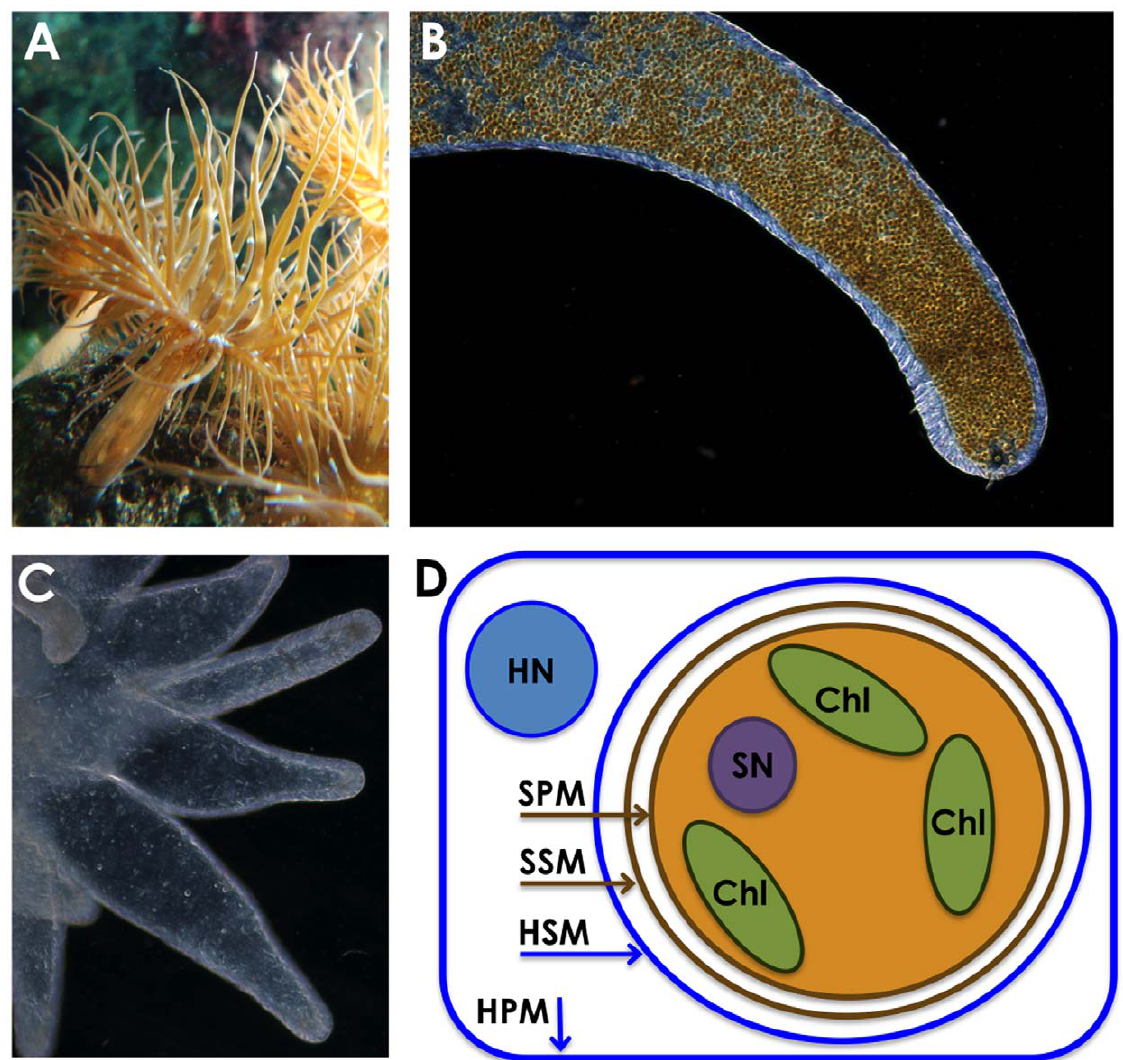
Figure 1. The symbiosis between the sea anemone Aiptasiapallida and the dinoflagellate Symbiodinium . Panel A: Symbiotic polyps of Aiptasia pallida demonstrate a golden brown color conferred on them by photosynthetic pigments from Symbiodinium . Panel B: A single tentacle from a symbiotic polyp contains thousands of individual Symbiodinium cells visible as small golden brown spheres within the gastrodermal tissue of the tentacle (epidermal tissue does not contain symbionts and is visible as the thin transparent layer at the periphery of the tentacle). Panel C: Four tentacles from an aposymbiotic polyp demonstrate the absence of Symbiodinium in the gastrodermis. Panel D: A schematic diagram of the intracellular arrangement of membranes of the host (blue) and symbiont (brown). The symbiont lives enclosed in the symbiosome, a membrane- bound compartment that arises from the host phagosome but that likely is modified upon establishment. HN=host nucleus, SN=symbiont nucleus, Chl=symbiont chloroplasts, HPM=plasma membrane of the host cell, SPM=plasma membrane of the symbiont cell, SSM=putative symbiosome membrane contributed by the symbiont shedding of external membrane, HSM=symbiosome membrane that arises from the phagosome membrane produced when the host takes up the symbiont into the host cell via